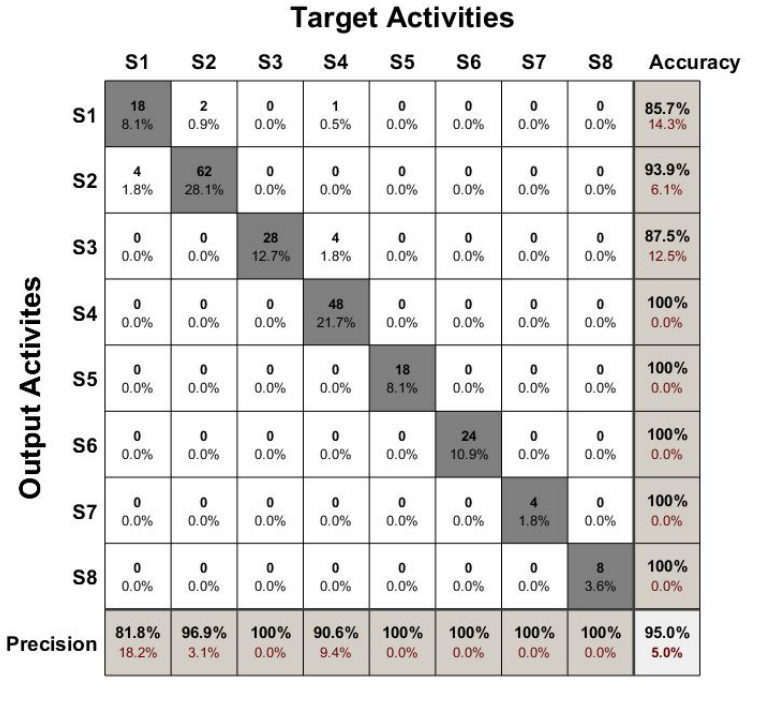
Figure 8. Confusion matrix plot for ADL recognition